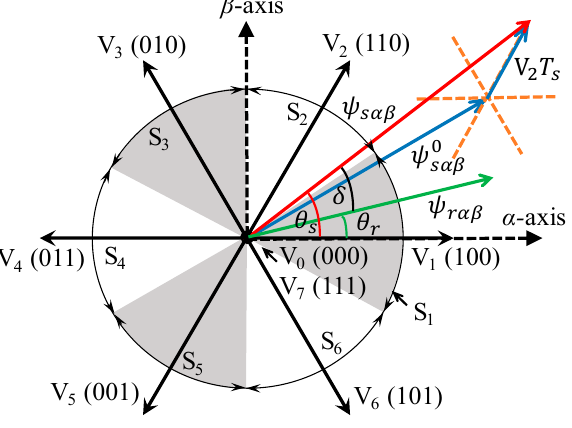
Figure 2. Basic concept of DTC .